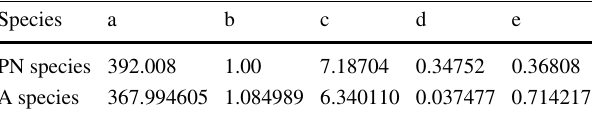
Table 7 Constants of Eq. 15